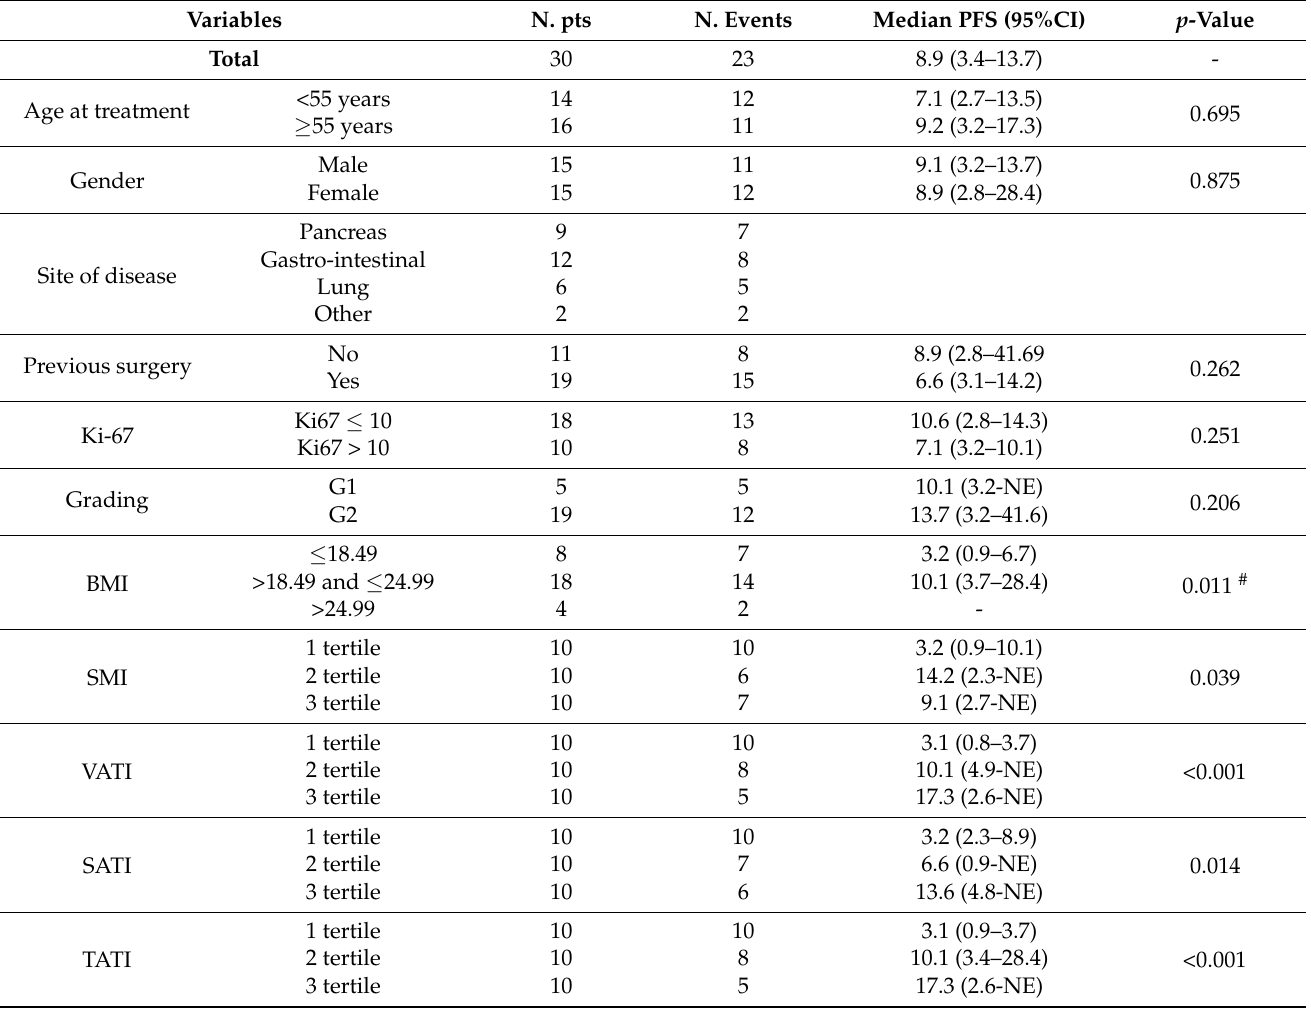
Table 4. Progression-free survival by